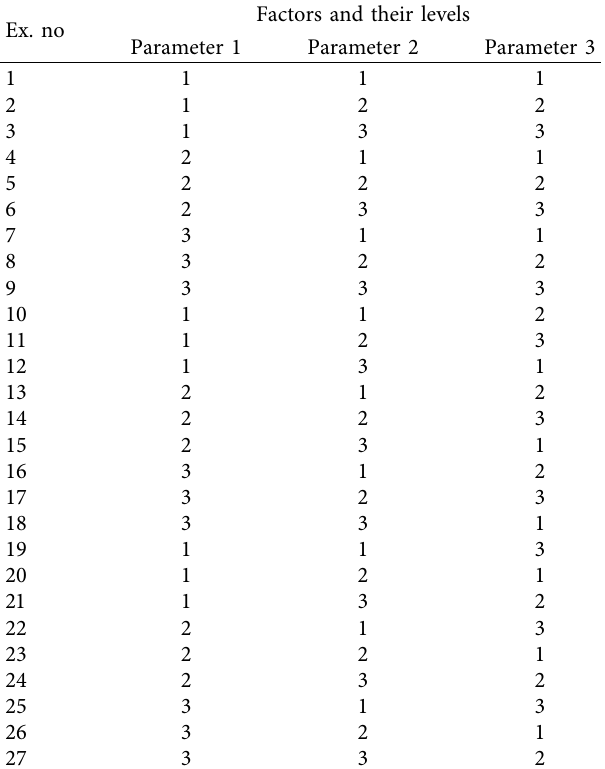
Table 5: Taguchi L27 OA showing 27 experiments. Ex.